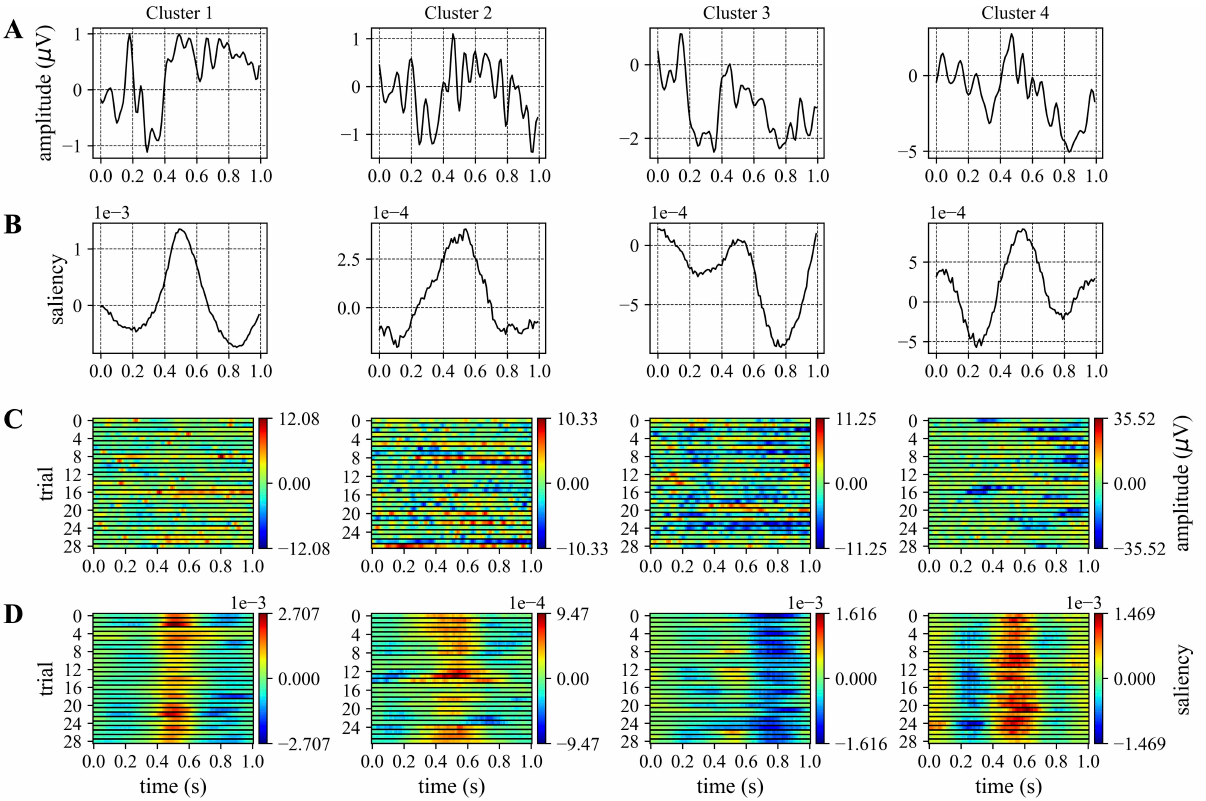
Fig. 10. Comparison between CNN-derived saliency and EEG-derived representations at single-subject and single-trial levels: target. These representations are displayed for one representative subject for each of the four clusters of Fig. 8 (each column of Fig. 10 is related to a specific cluster). (A,B) Evoked potentials directly derived from EEG trials (Fig. 10A) and temporal WS CNN-derived saliency patterns (Fig. 10B) at the level of single subject; both these representations involve averaging across trials of the same condition and across a subset of electrodes (P3, P1, Pz, P2, P4, PO3, POz, PO4). See Section 2.3.5 for details. (C,D) Single EEG trials (Fig. 10C) and WS CNN-derived saliency pattern (Fig. 10D) at the level of single trials: each row corresponds to a trial, and the representation in each row still involves averaging across the subset of electrodes. In practice, the patterns in Fig. 10A and 10B correspond to averaging, across the rows, the representations in Fig. 10C and 10D,